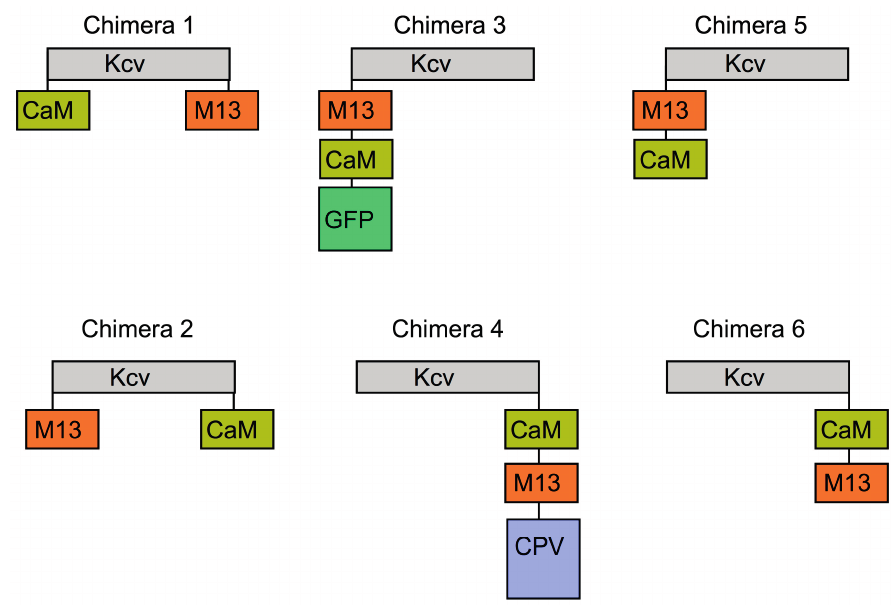
Figure 2. Schematic representation of the chimerae. Chimerae 1 to 6 were constructed by fusing the Kcv monomer (grey box) with CaM and its interacting peptide M13 in different positions. Chimera 3 and 4 contained also the Cyan Fluorescent Protein (CFP) and the Circularly Permuted Venus peptide (CPV)